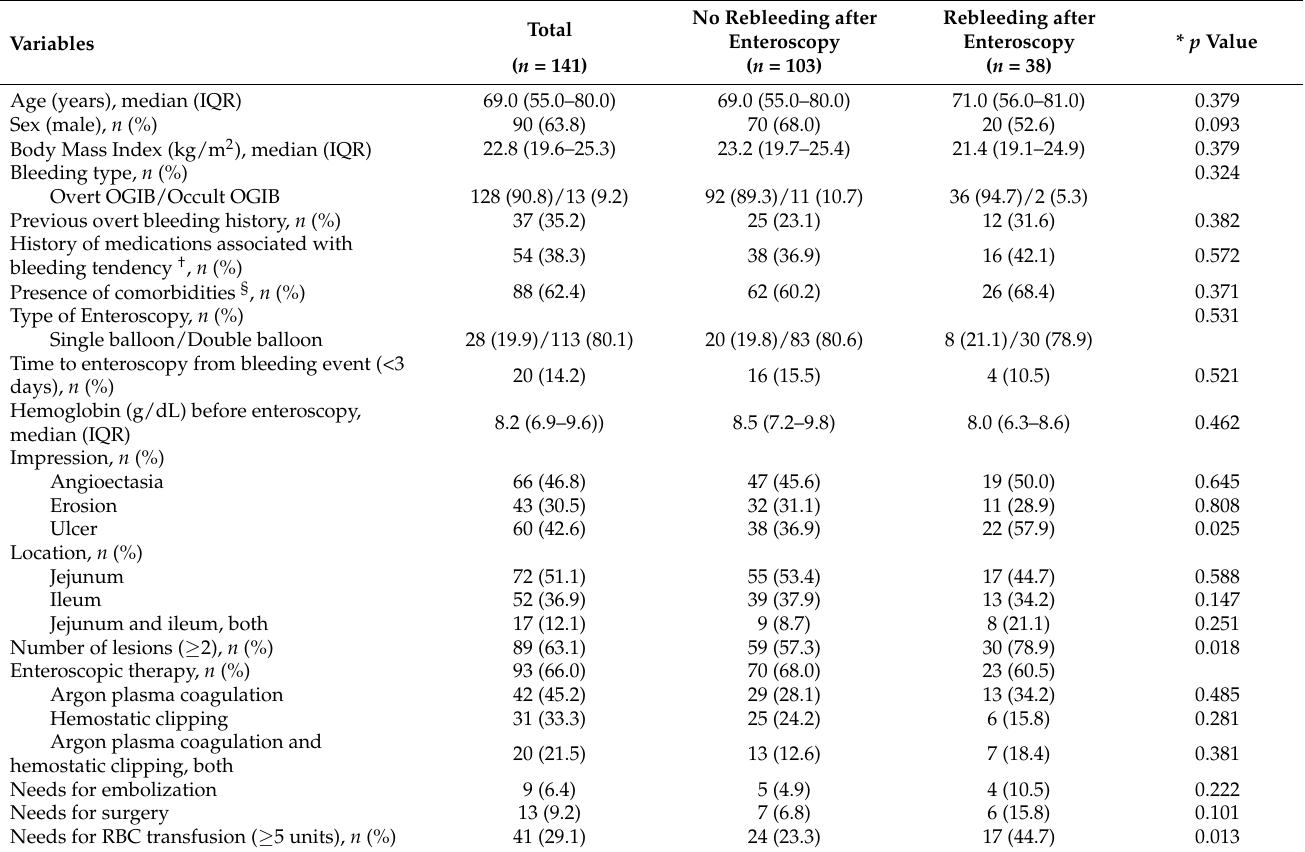
Table 1. Baseline